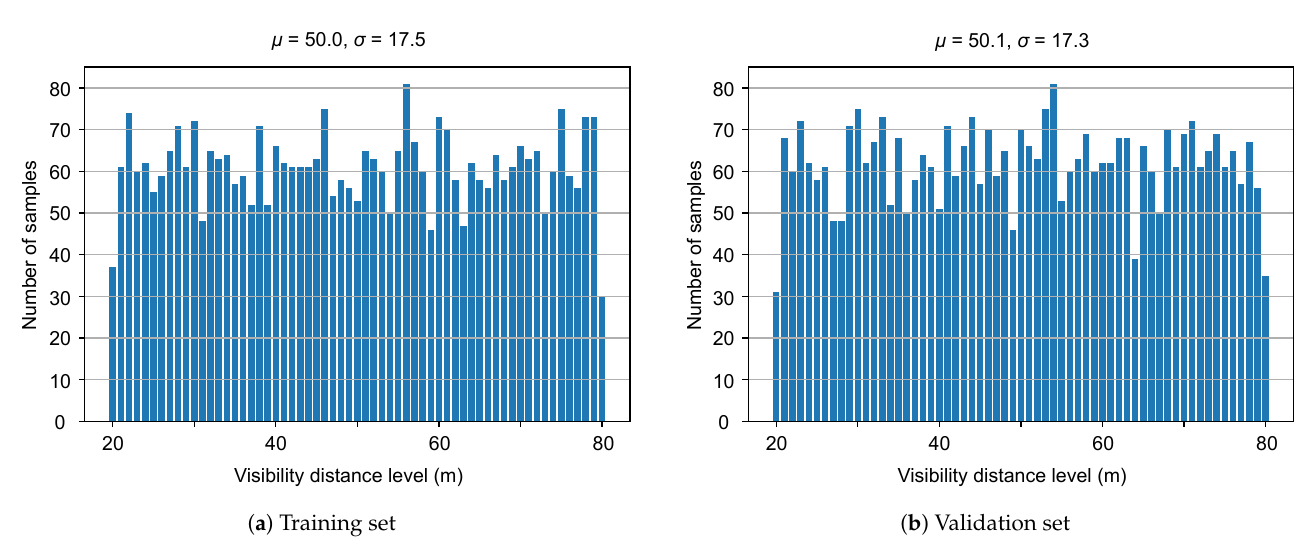
Figure 4. Distribution of MOR of different parts in the Multifog